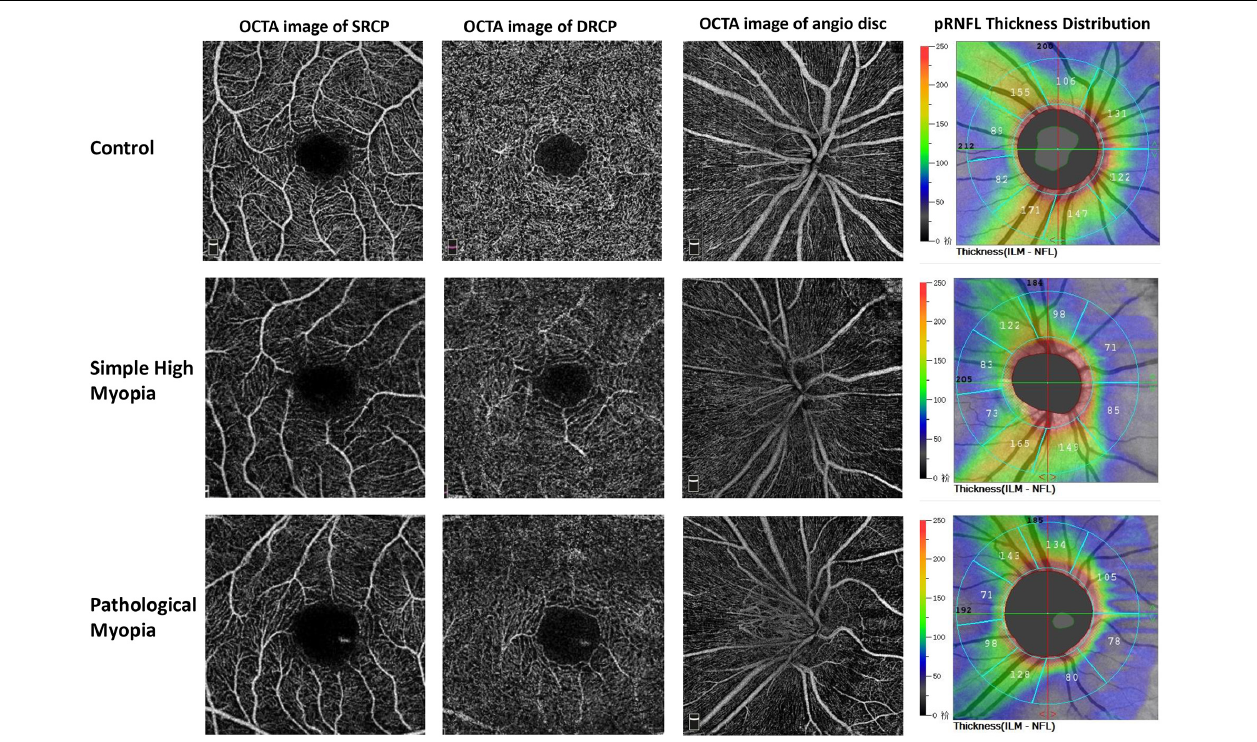
FIGURE 1 | Representative OCT-A images of the control, simple high myopia, and pathological myopia. OCT-A, optical coherence tomography angiography; SRCP, superficial retinal capillary plexus; DRCP, deep retinal capillary plexus; pRNFL, peripapillary retinal nerve fiber layer.